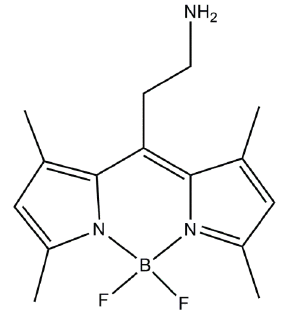
Figure 7. Chemical structure of Product 3 .